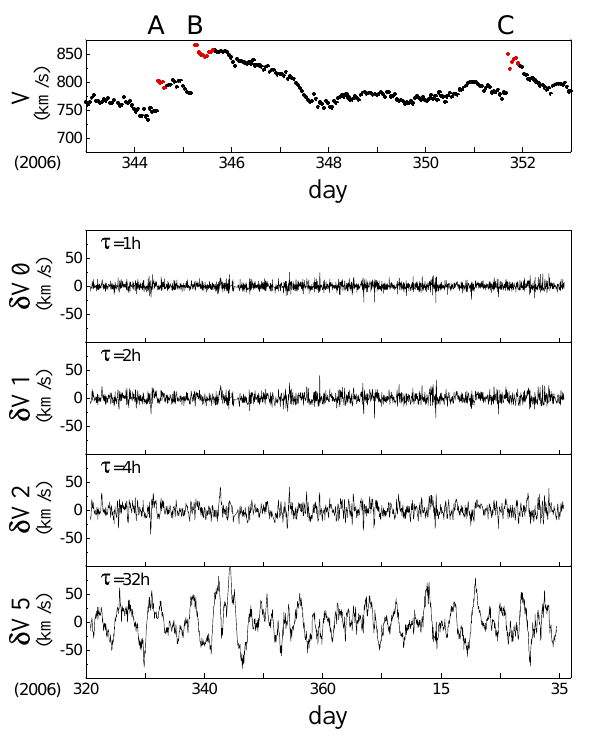
Fig. 7. From top to bottom: standard deviation, skewness, and kur- tosis versus time lag τ . The samples S1, N1, and N3 are the same as in Fig. 3, while for the third orbit southern phase the sample S3 ∗ (derived from S3 by removing the data points shown in red in Fig. 6) is